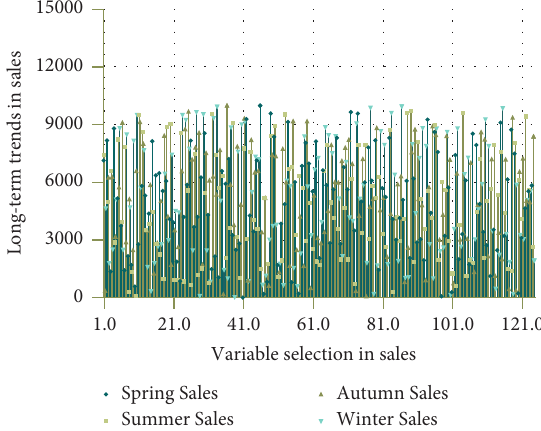
Figure 3: Data analysis of MCCB clothing